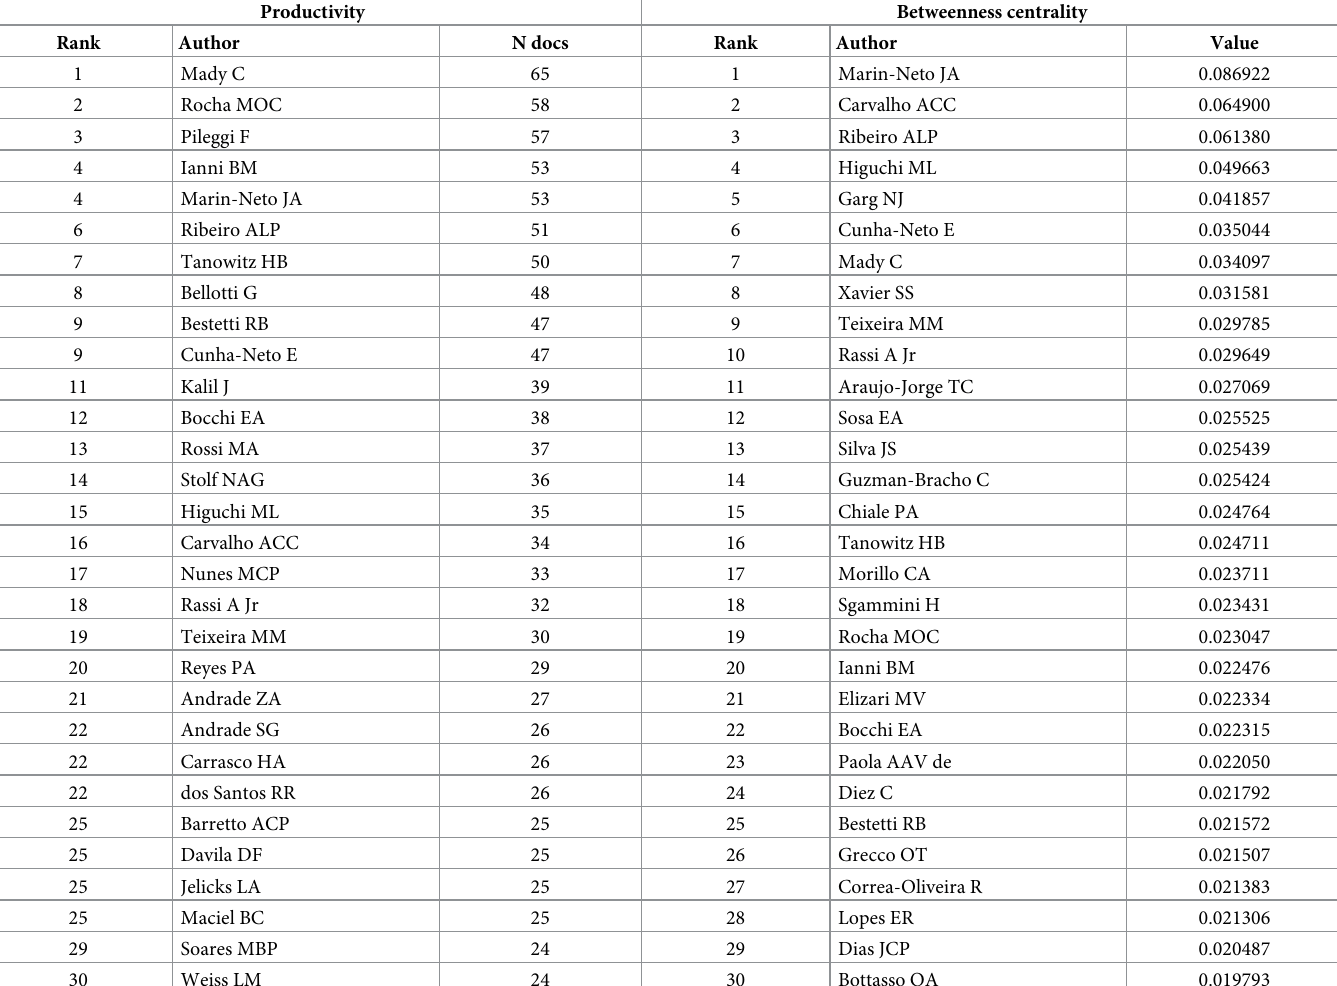
Table 7. Most productive authors ( > 50 records) and authors with highest values of betweenness centrality in Chagas cardiomyopathy papers indexed in